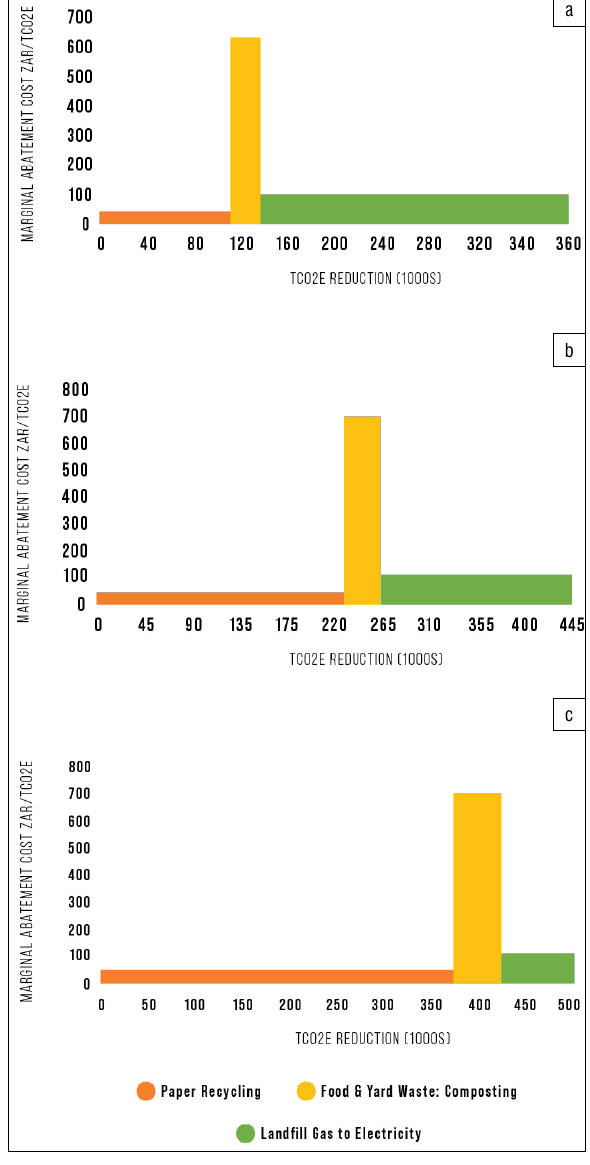
Figure 6: Marginal abatement cost curve for the waste sector in (a) 2030, (b) 2040 and (c)